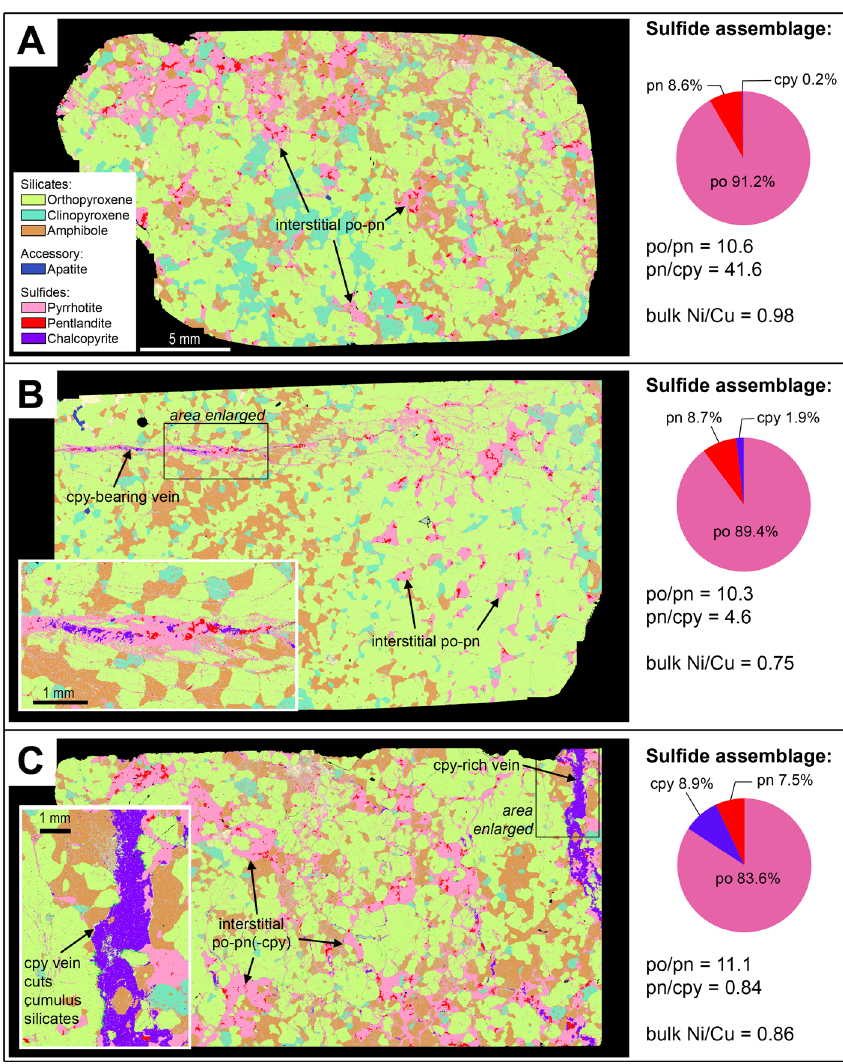
Fig. 5 ZEISS Mineralogic maps of clinopyroxene-amphibole-orthopyroxene cumulates and quantitative (wt%) de fi nition of sul fi de assemblages in polished thin sections from Sella Bassa. A Interstitial sul fi des dominated by pyrrhotite (po) and pentlandite (po) (sample IV18-SB1); B Interstitial pyrrhotite-pentlandite blebs and a vein of chalcopyrite (cpy)-pyrrhotite-pentlandite (sample IV18-SB4); and C Interstitial sul fi des dominated by pyrrhotite and pentlandite with minor chalcopyrite and a vein of dominantly chalcopyrite (Sample IV18-SB3). Quantitative data and sul fi de ratios are also presented in Supplementary